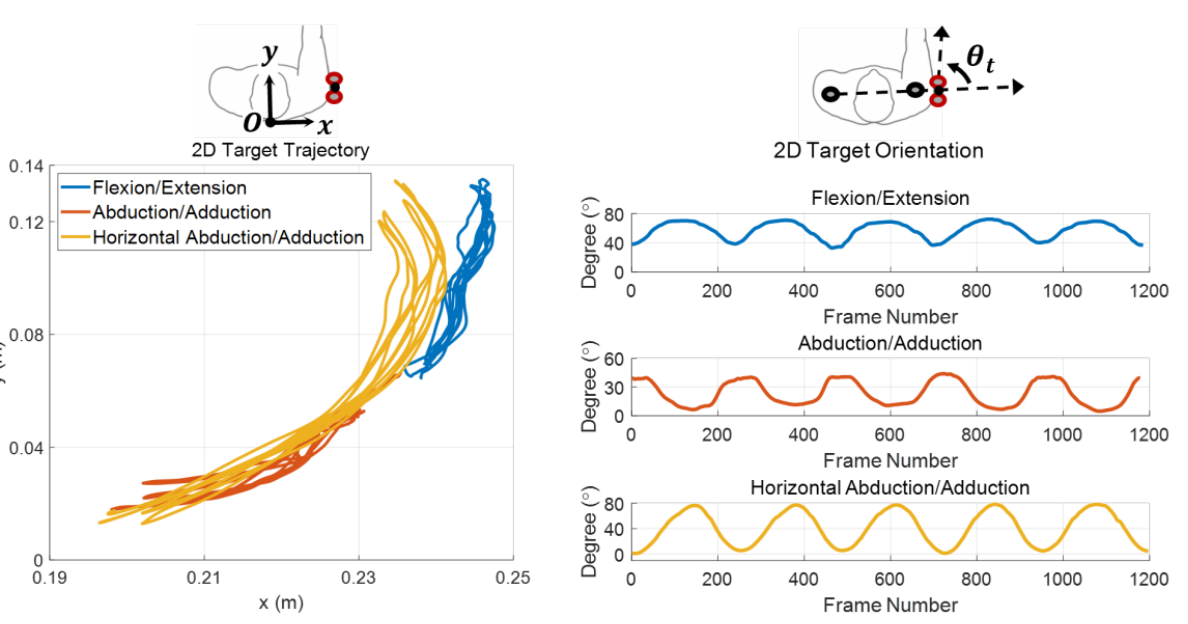
Figure 4. Extracted target trajectory and orientation for five cycles of each motion on the coordinate system based on the thorax.